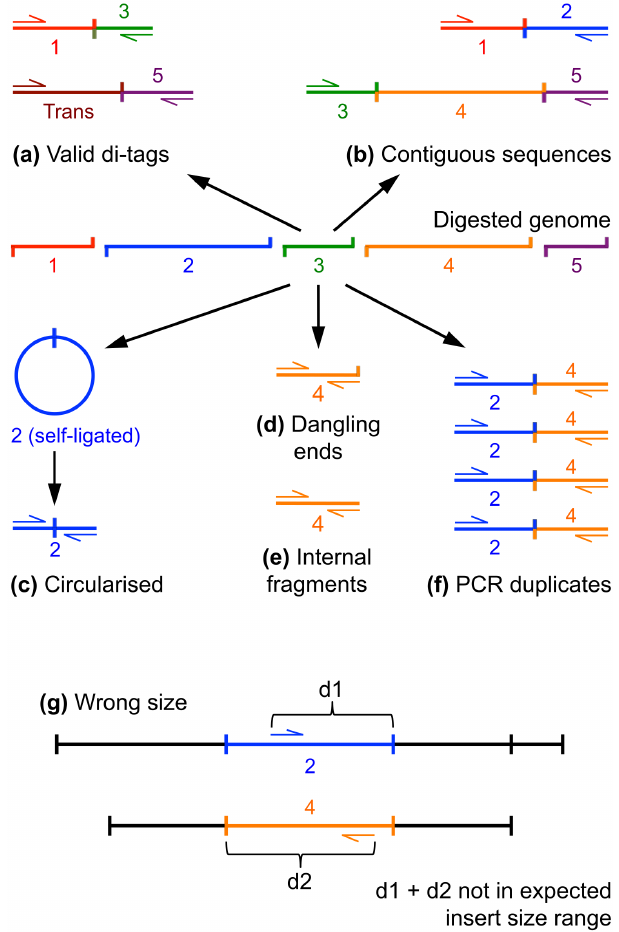
Figure 2. Overview of experimental artefacts generated by the Hi-C experimental protocol. The schematic shows the genome digested into 5 restriction fragments. These fragments may subsequently ligate to each other, or fragments derived from another chromosome, forming valid cis or trans di-tags respectively ( a ). In contrast, re-ligation or incomplete digestion leads to the generation of invalid contiguous sequences ( b ). Another common artefact occurs when the sequenced read-pair maps to a single restriction fragment ( c ), ( d ) & ( e ). Further, PCR may result in a fragment being copied multiple times ( f ). Di-tags are also rejected when the mapped reads are positioned too far away from the putative restriction enzyme cut-site than allowed by the experimental size-selection step ( g